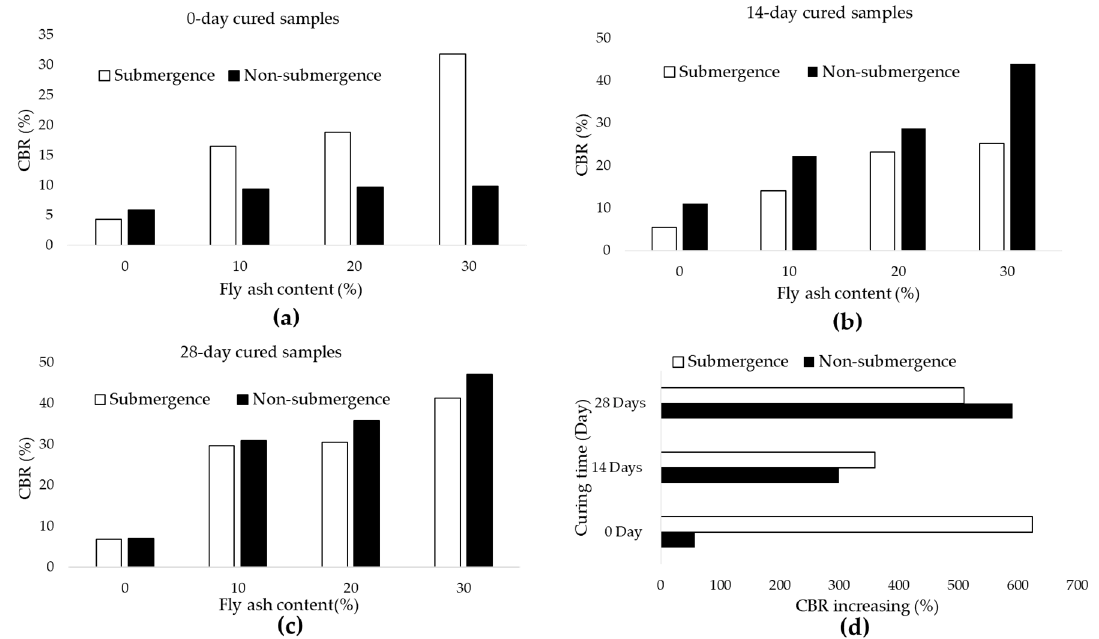
Figure 3. The CBR value of non-submergence and submergence conditions at different FA ratios and curing times of specimens: ( a ) zero days; ( b ) 14 days; ( c ) 28 days; and ( d ) CBR increasing.